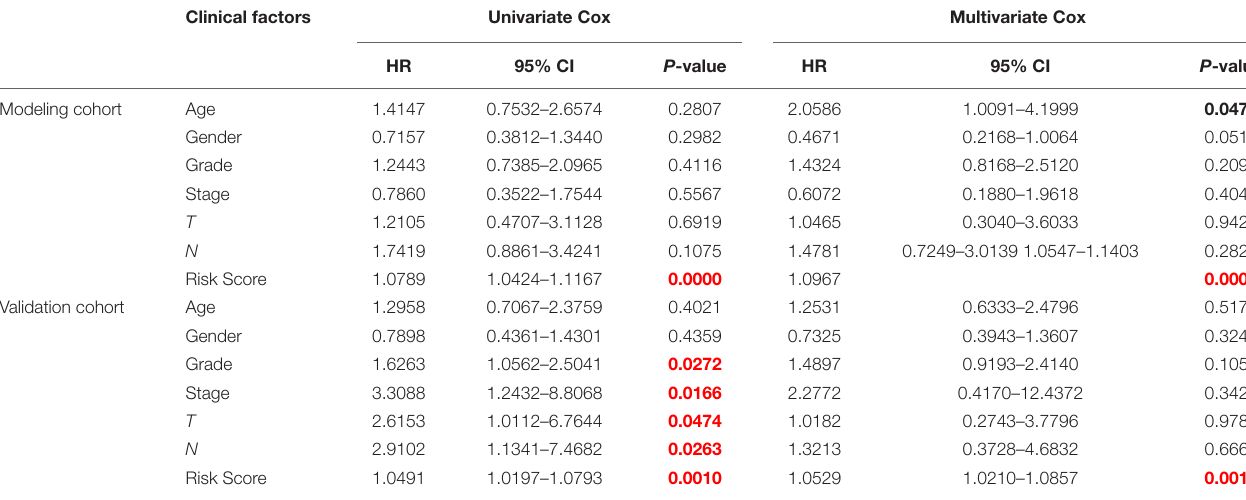
TABLE 4 | Effects of clinical factors and risk score on prognosis of PAAD patients analyzed by univariate and multivariate Cox analysis.